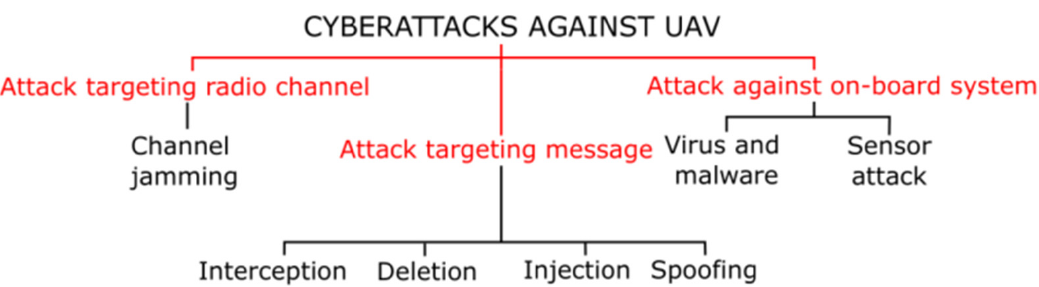
Figure 9. Classification of cyberattacks against UAVs.